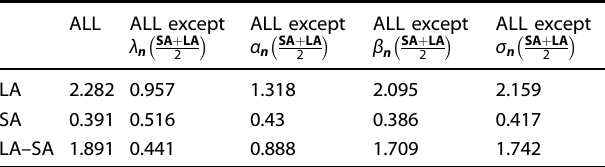
Table 1. IOD variance from sensitivity experiment of simple IOD